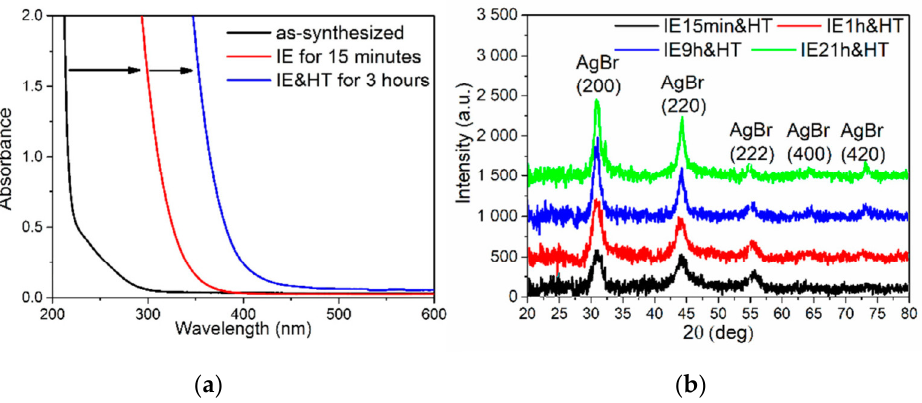
Figure 8. ( a ) Absorbance spectra of PTR-Br glass samples before and after the IE and heat treatment at 500 ◦ C for 3 h. ( b ) XRD patterns of PTR-Br glass samples ion-exchanged for different time and heat-treated at 500 °С for 9 h.